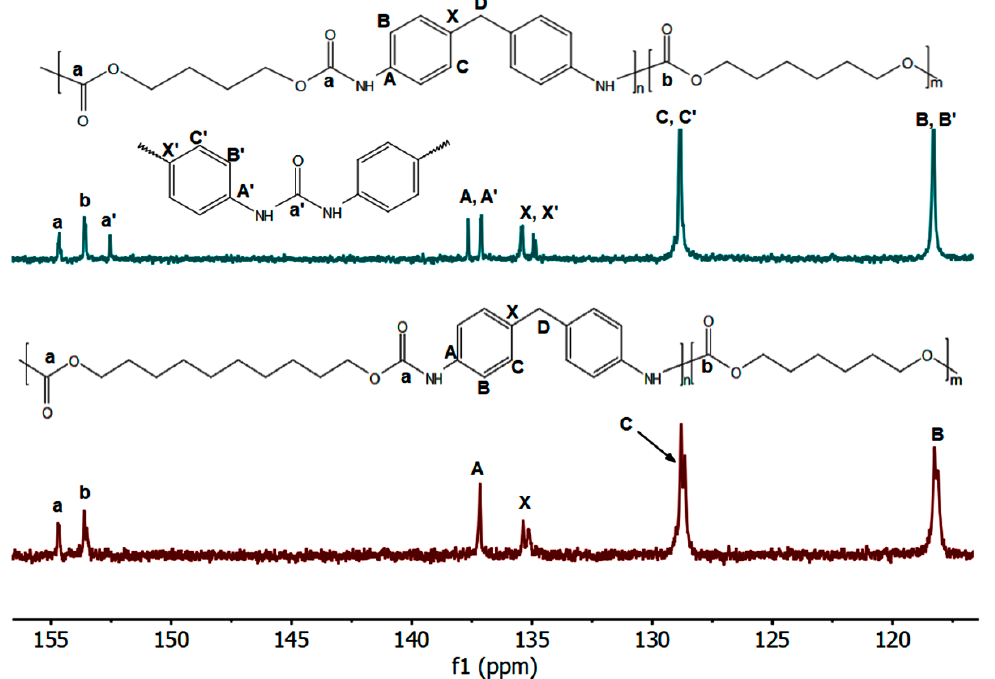
Figure 5. The comparison of the NIPCU_1_2 ( up ) and NIPCU_1_10 ( down ) structures based on 13 C NMR spectroscopy.